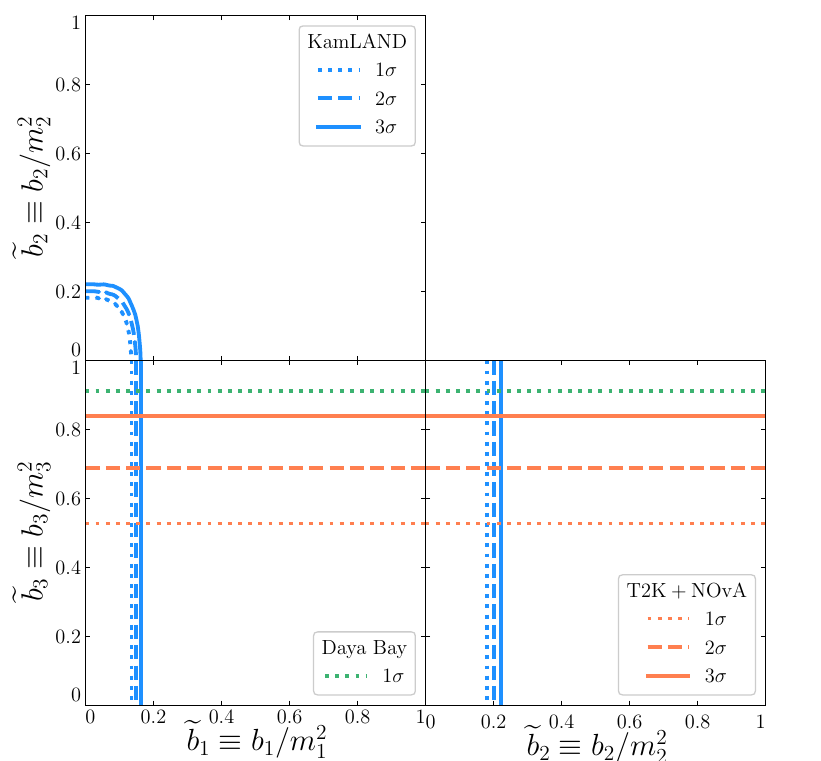
Figure 9. Current constraints from KamLAND (blue), Daya Bay ( 1 σ only, green), and long- baseline ν µ disappearance measurements from T2K and NOvA (orange) at 1 , 2 , and 3 σ CL (dotted, dashed and solid respectively) on the reduced breadths b i , relative to the overall neutrino-masses- squared when we assume m 1 = 10 − 2 eV.